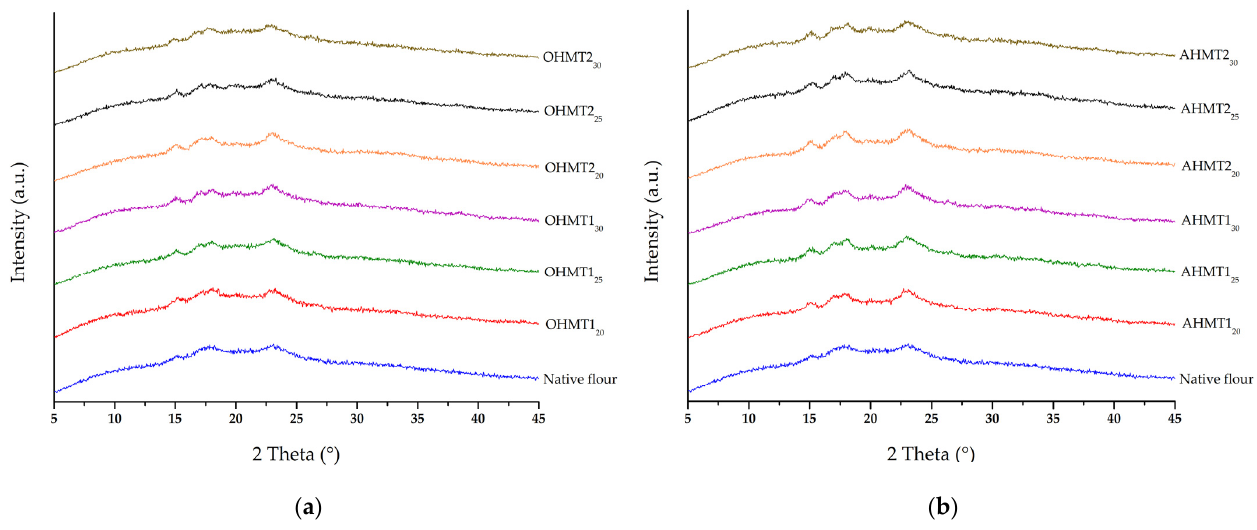
Figure 2. The native and HMT purple rice fl our were analyzed using X-ray di ff raction pa tt erns after two treatments: ( a ) oven heat–moisture treatment (OHMT) and ( b ) autoclave heat–moisture treat- ment (AHMT) .